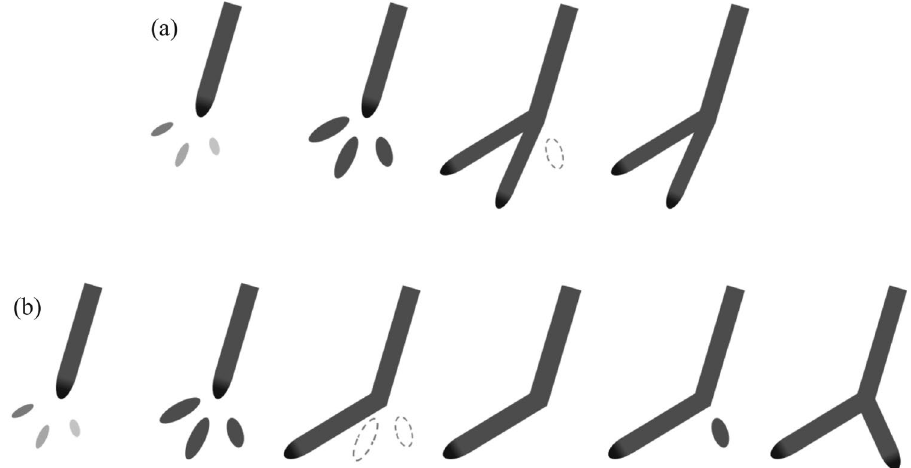
Figure 4. Sketch diagram of two kinds of leader branching mechanism, ( a ) occurrence of multiple space leaders and their connection to the same channel tip within a step cycle, ( b ) multiple space leaders and the re-activation of an interrupted space leader after a step towards a different direction has previously occurred.